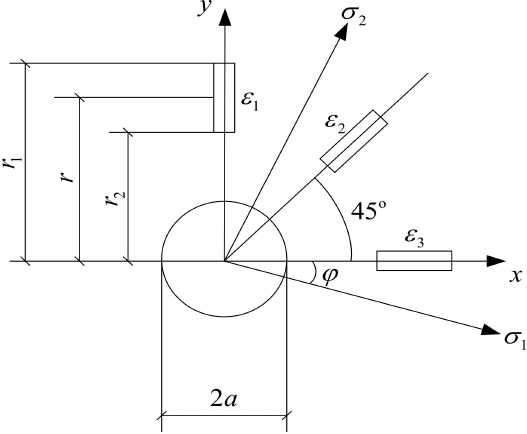
Figure 3. Principle of blind-hole drilling